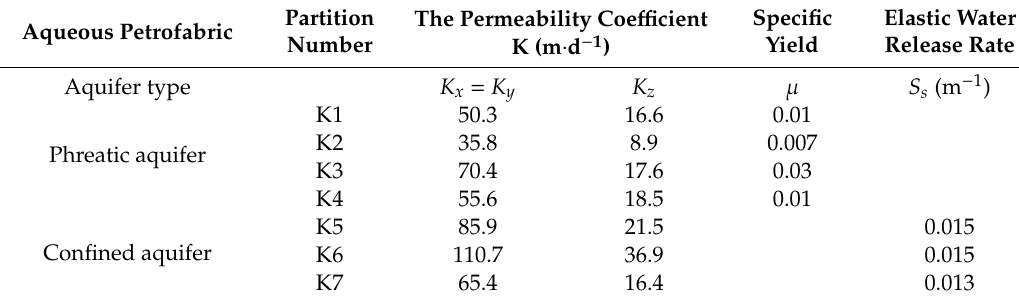
Table 3. Hydrogeological parameters of the